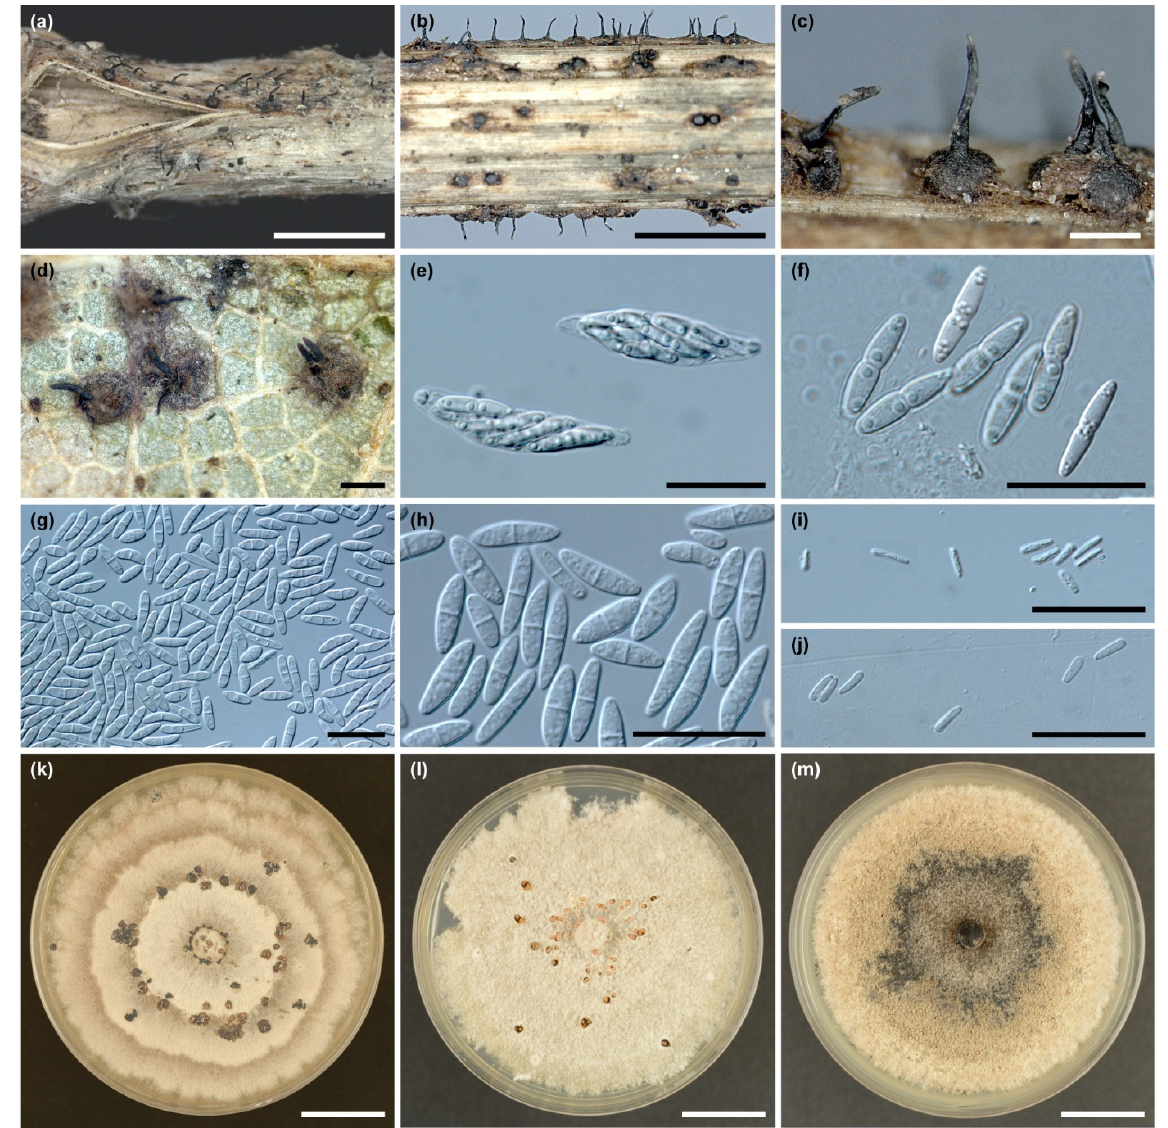
Figure 3. Morphology of Apiognomonia hystrix on natural substrates and in cultures. Perithecia on overwintered petioles of F. excelsior ( a ) and A. pseudoplatanus ( b , c ), perithecia on A. pseudoplatanus leaf, before falling ( d ), asci ( e ) and ascospores ( f ) from perithecium on petiole of A. pseudoplatanus in vivo, conidia developed in conidiomata on A. pseudoplatanus leaf in vivo ( g ), conidia from conidiomata in vitro ( h ), microconidia developed on A. pseudoplatanus leaf in vivo ( i ) and in conidiomata in vitro ( j ), colonies on MEA with varying structure and pigmentation, visible conidial matrix (20 °C, 3 weeks) ( k – m ); scale bars: ( a , b ) = 2 mm, ( c , d ) = 200 μ m, ( e – j ) = 20 μ m, ( k – m ) = 20 mm.